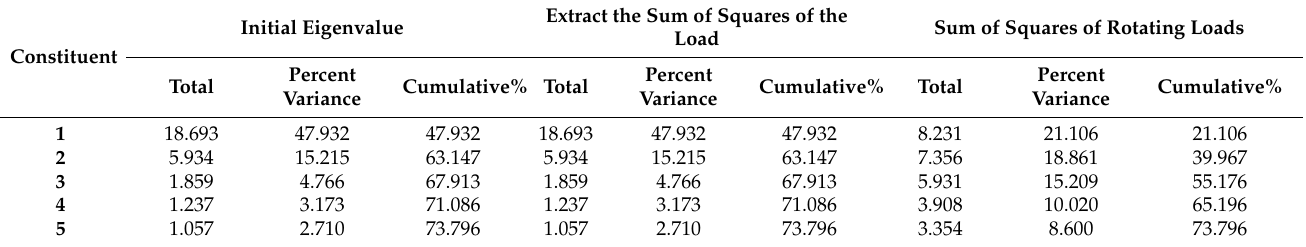
Table 4. Subjective evaluation and principal component analysis of hotel room types with different decoration styles.